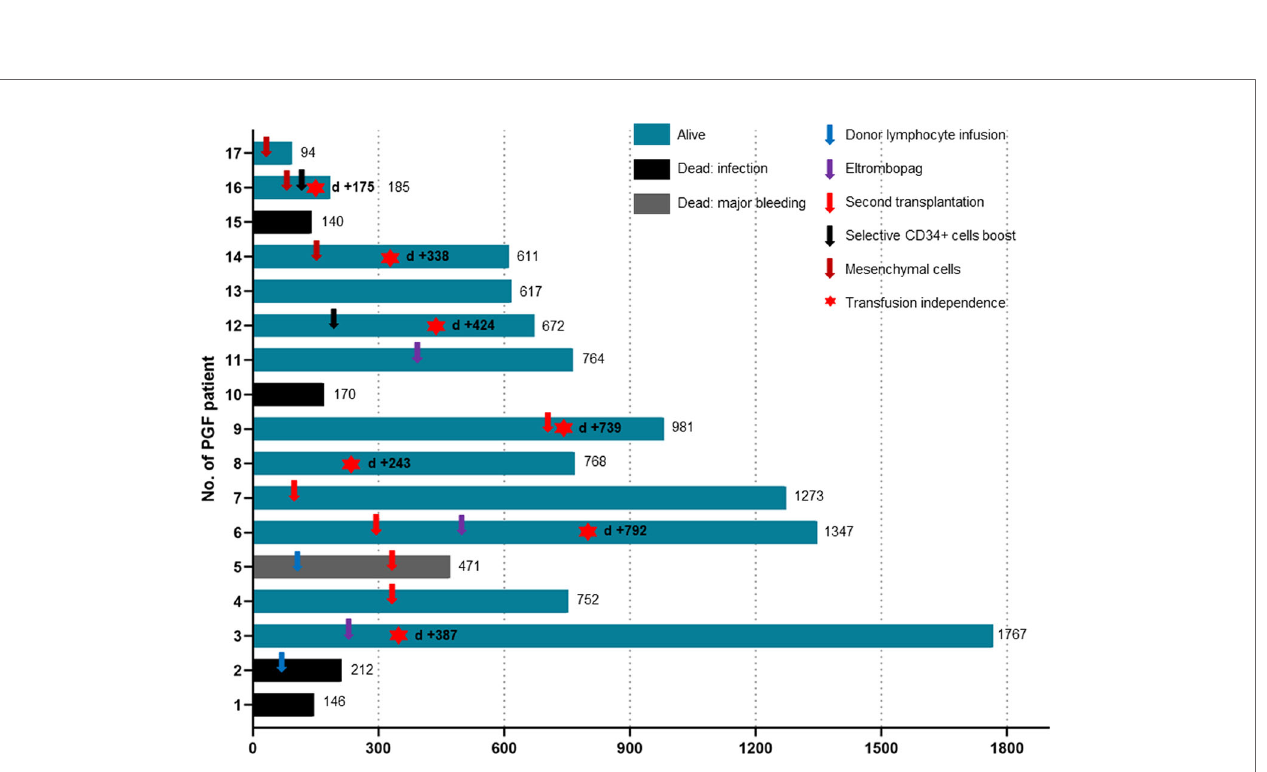
FIGURE 3 | Treatment and outcomes in sPGF